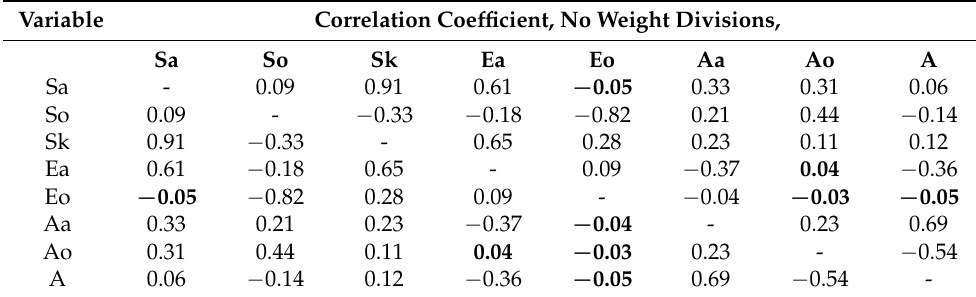
Table 4. Correlation coefficient for indicators of technical and tactical preparations. Variable